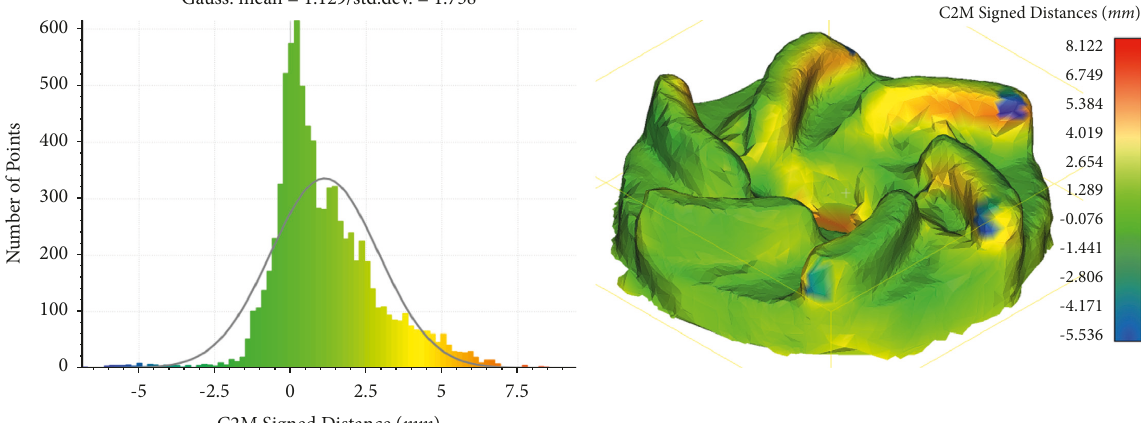
Figure 34: Cloud-to-mesh distance of near-net-shaped CAD model and scanned model of component realized through integrated substrate